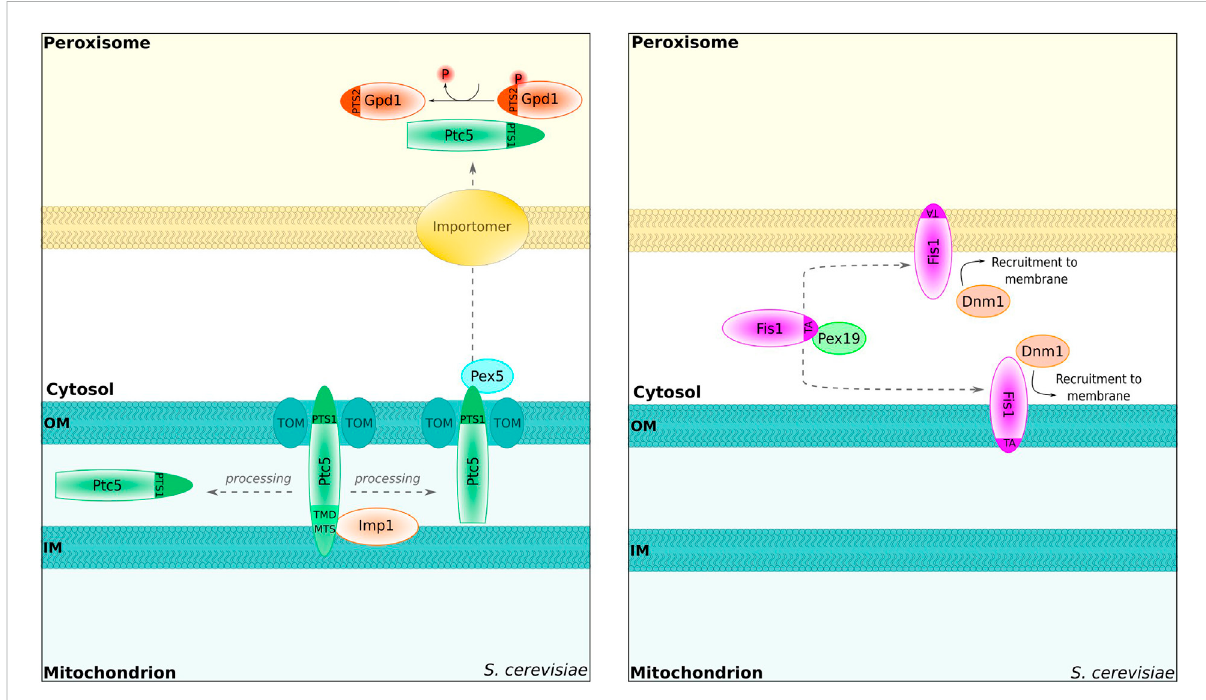
FIGURE 2 Proteins shared betweenperoxisomes and mitochondria. S. cerevisiae Ptc5p can reach the peroxisome via mitochondrialtransit. The protein is proteolytically processed inside of the inner mitochondrial membrane by the peptidase Imp1 and subsequently translocated to peroxisomes in a Pex5-dependent manner [left; Stehlik et al. (2020)]. Inside of the peroxisome, Ptc5 dephosphorylates Gpd1 [left; Stehlik et al. (2020)]. TOM, translocator of the outer mitochondrial membrane. Importomer, complex for peroxisomal matrix protein import [Walter and Erdmann (2019)]. Thetail-anchoredproteinFis1isinvolvedinthe fi ssionprocessofperoxisomesandmitochondria[right;Kuravietal.(2006)].Targetingisregulatedby Pex19 [Cichocki et al. (2018)]. Dnm1, dynamin-related GTPase for peroxisome fi ssion Kuravi et al.